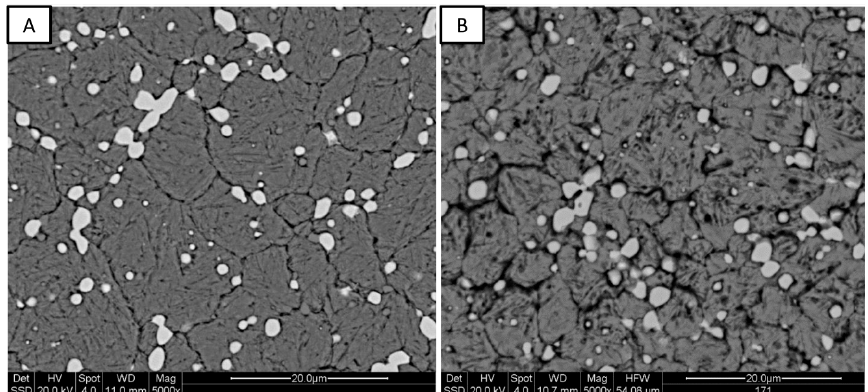
Figure 2. SEM micrographs of ( A ) M2 and ( B ) M2 ‐ C samples.